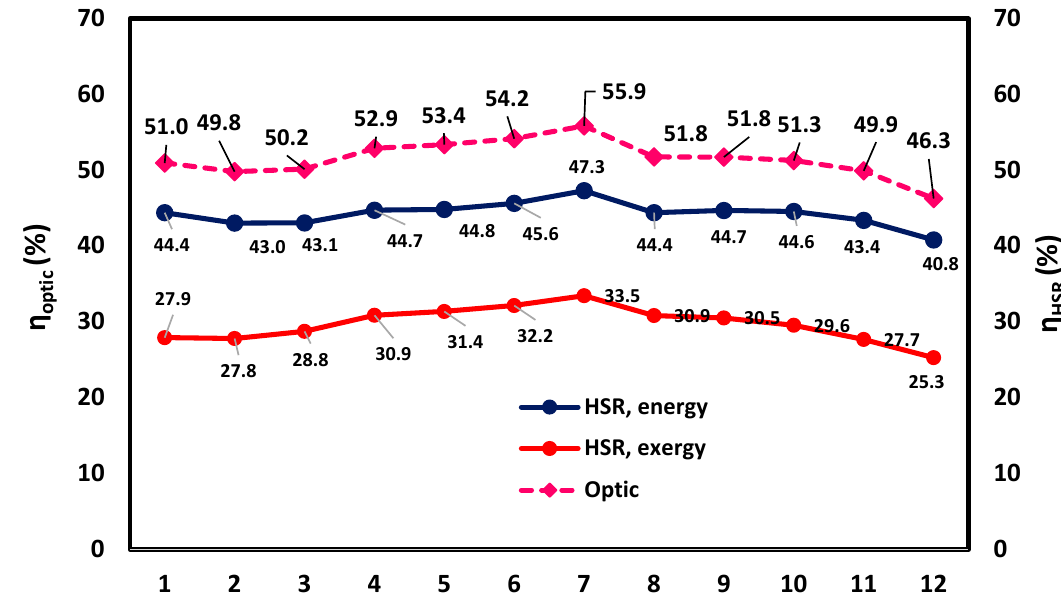
Figure 6. Monthly average optic efficiency of the heliostat in different months of a year.